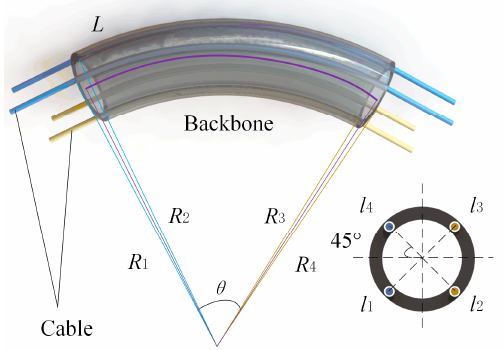
part is driven by the change in the cable length in the drive space ( l ).